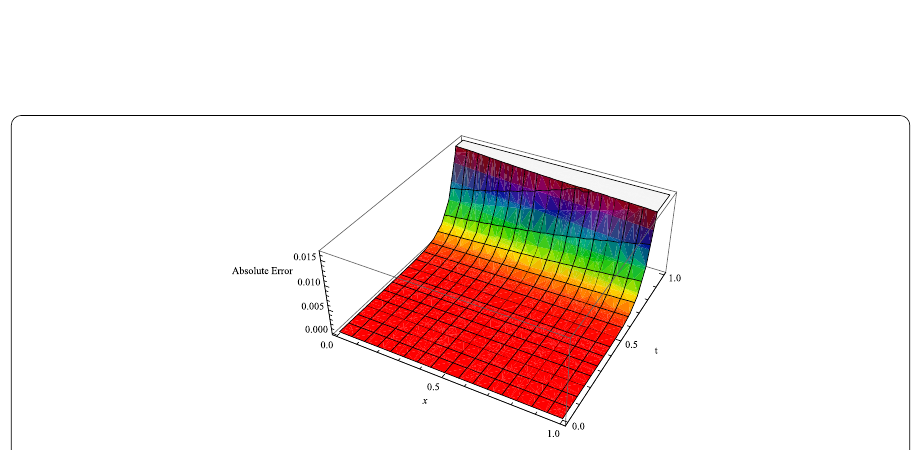
Figure 10 Plot of absolute error E 7 ( w ) = | w ( x , t ) – w 7 ( x , t ) | using HATM when λ = 1